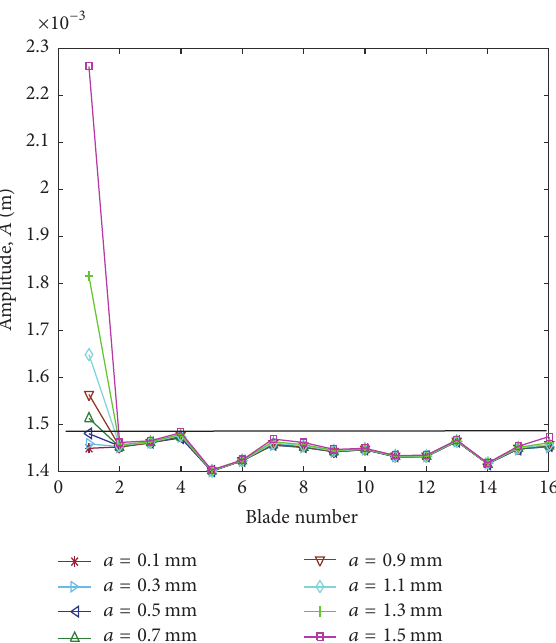
Figure 14: Vibration amplitudes of MRBs under different 𝑎